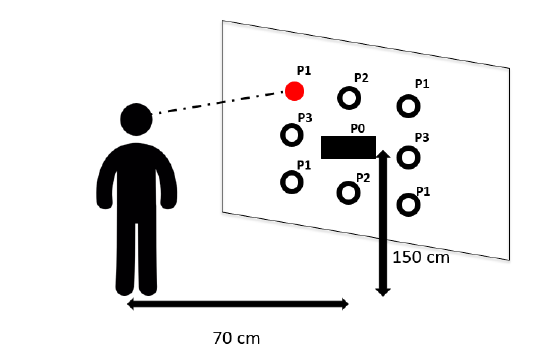
Figure 8. The technical setup to evaluate the proposed gaze estimator. A person is standing in front of the panel where nine circular markers were stuck. The person is asked to look at each of the markers on the panel, in a predefined order, and then to confirm that the markers are in their requisite positions. In the example, the marker on the upper left of the panel is being